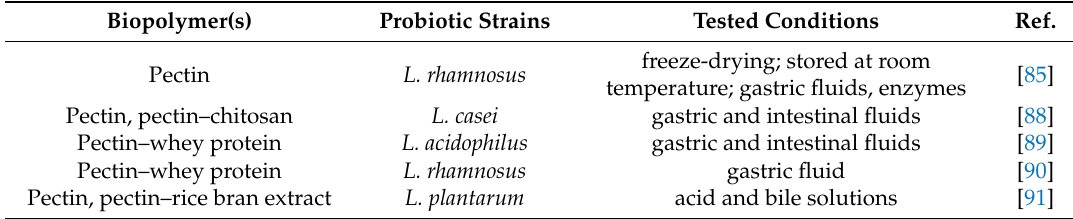
Table 4. Pectin-based hydrogels used as delivery systems of selected probiotic